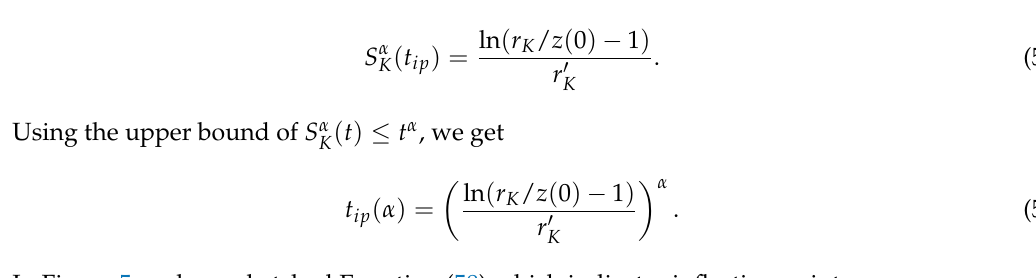
Figure 4. Graph of upper bound of fractal logistic function and its fractal